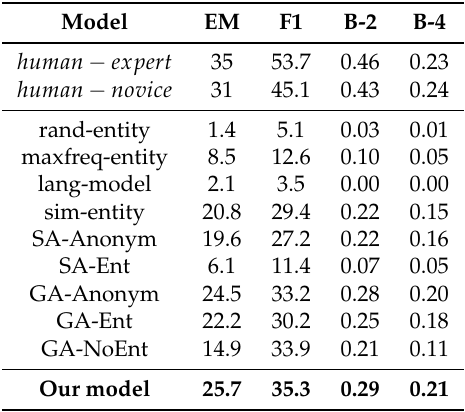
Table 2. Results on test set for CliCR (EM and F1 scores are in percentage) [7].